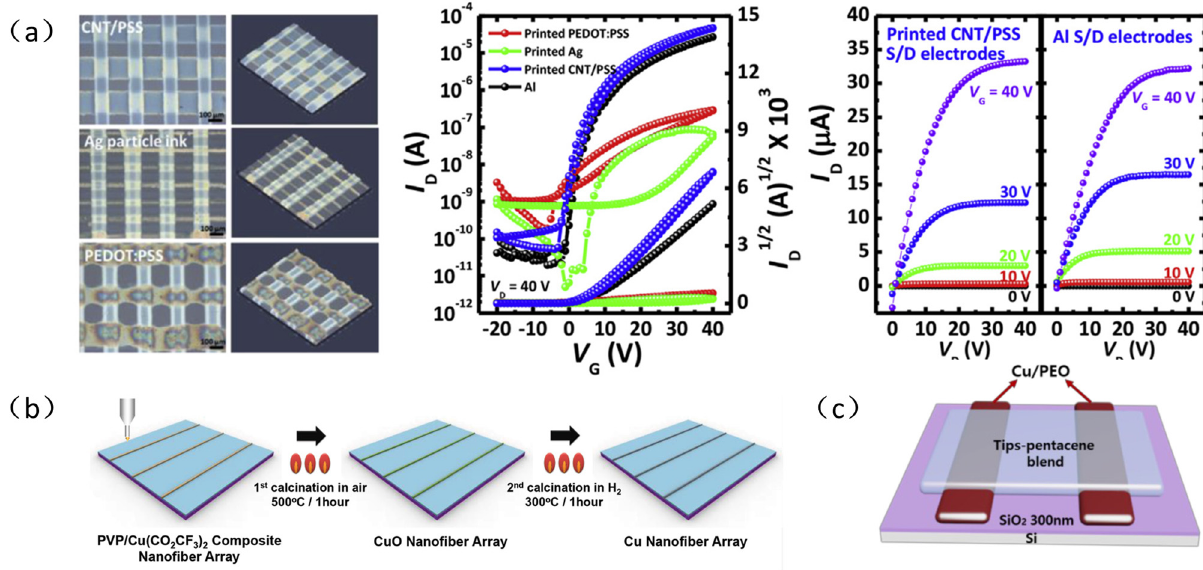
Figure 11: ( a ) ZnO: In thin fi lm transistors made by E - jet printing with three kinds of conductive materials ( MWCNT/PSS, Ag nanoparticles, and PEDOT:PSS ) and transfer characteristics and output characteristics. Reproduced from ref. [ 136 ] with permission from Elsevier. ( b ) Diagram of the preparation process of the copper nano fi ber array. Reproduced from ref. [ 137 ] with permission from Wiley - Blackwell. ( c ) Cu/PEO source/drain electrode fi eld - e ff ect transistors prepared by E - jet printing. Reproduced from ref. [ 138 ] with permission from